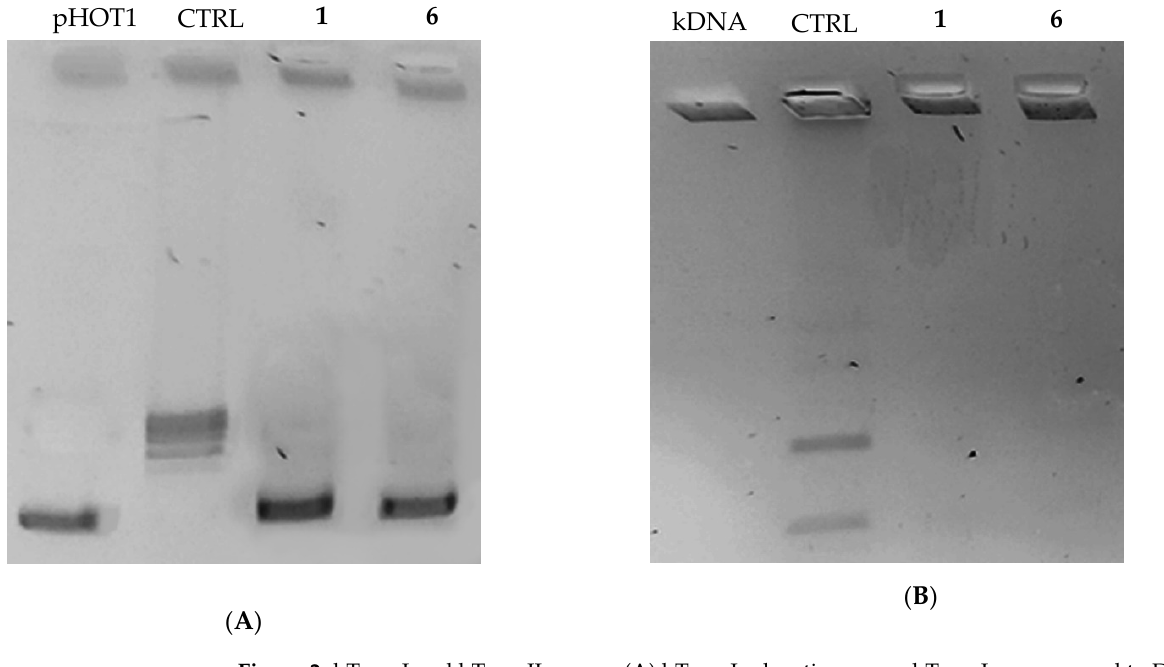
Figure 2. hTopo I and hTopo II assays. ( A ) hTopo I relaxation assay. hTopo I was exposed to DMSO (CTRL) or compounds 1 and 6 at the concentration of 1 µ M, then the products of hTopo I reaction were visualized on agarose gel; ( B ) hTopo II decatenation assay. hTopo II was exposed to DMSO (CTRL) or compounds 1 and 6 at the concentration 1 µ M. The hTopo II reaction products were visualized on agarose gel. pHOT1, supercoiled plasmid DNA; kDNA, kinetoplast DNA; CTRL, control (DMSO); 1 and 6 , tested compounds.